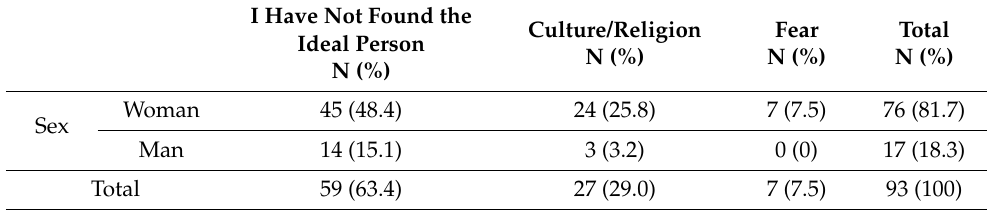
Table 2. Reasons of participants who had not had penetrative sex as a function of sex and religion